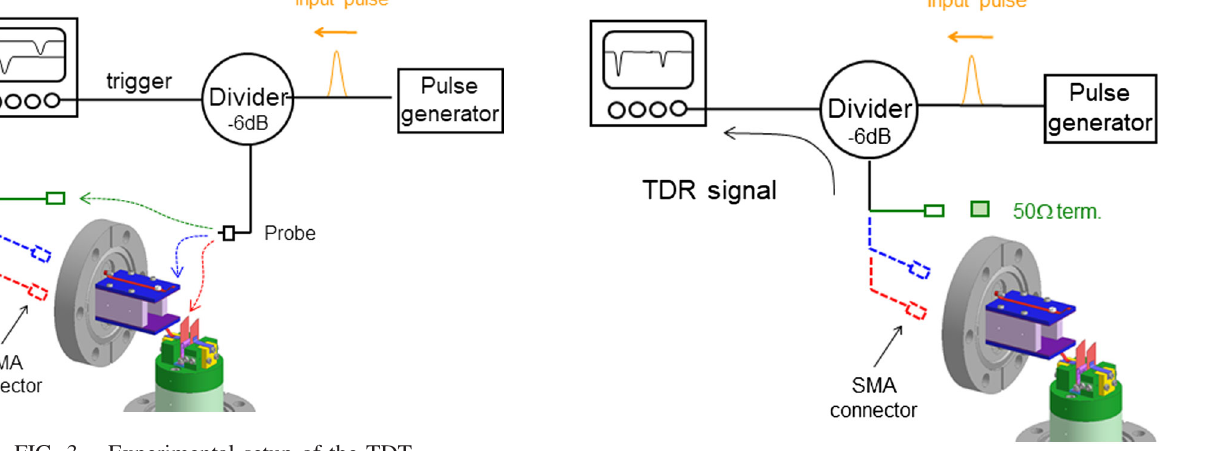
FIG. 5. Experimental setup of TDR.